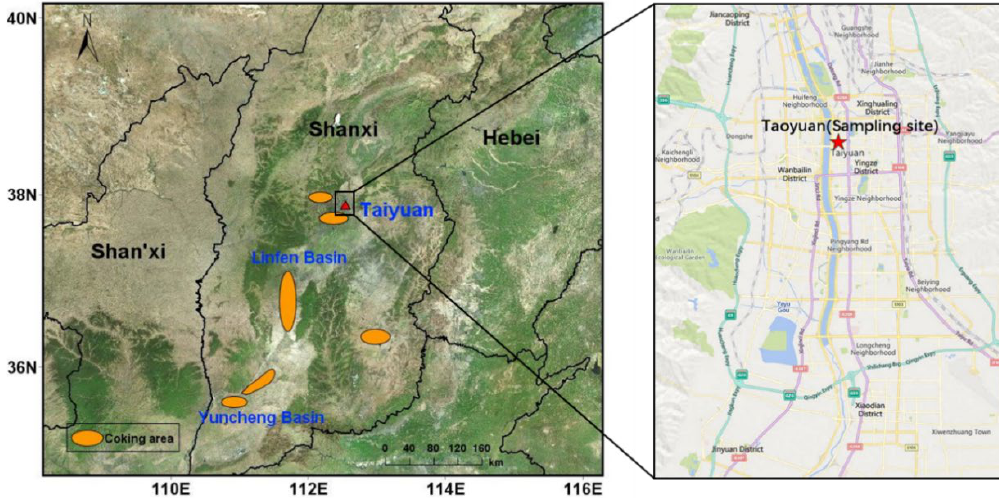
Figure 1. The location of sampling site in Taiyuan and distribution of coking areas in Shanxi province. Carbonyls were collected by a 2,4-dinitrophenylhydrazine (DNPH)-coated silica car- tridge (Sep-Pak DNPH-Silica Cartridges, 350 mg, Waters). A scrubber filled with potas-